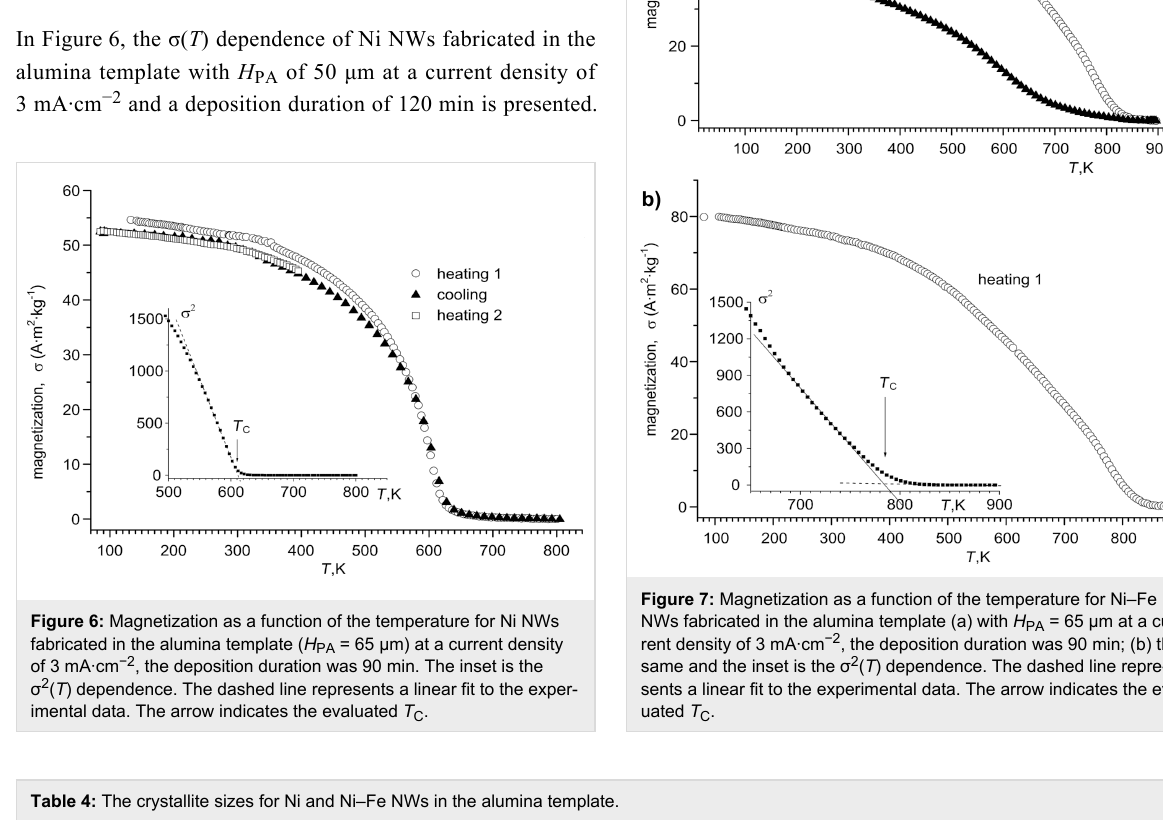
Table 4: The crystallite sizes for Ni and Ni–Fe NWs in the alumina template. sample Ni, NWs